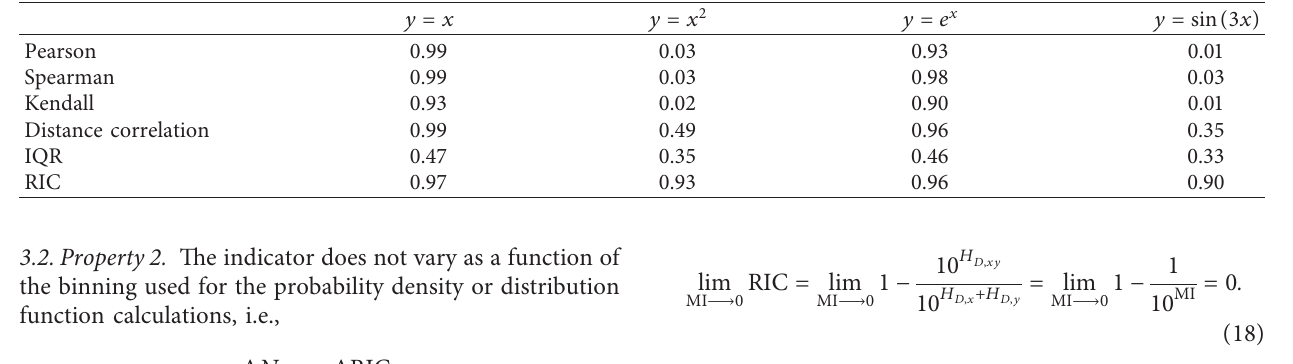
Table 1: The value of the various indicators for the cases of Figure